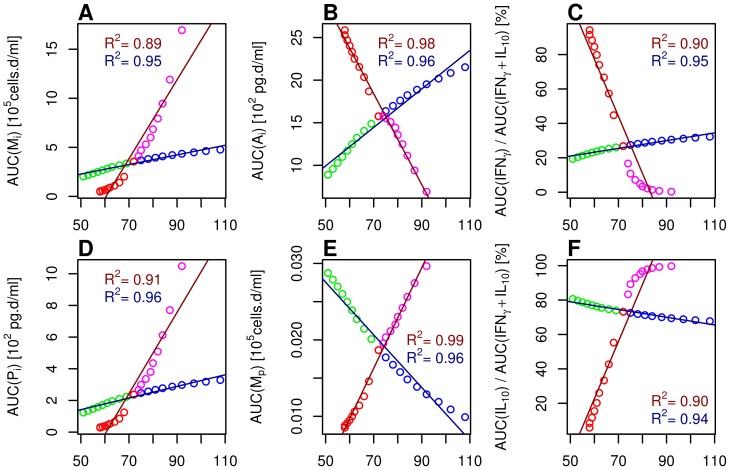
Linear regressions between the infection duration and immune components of interest.The immune components selected are the area under the curve (AUC) of A: infected macrophages (), B: innate antiviral cytokines (), D: pro-inflammatory cytokines (), and E: phagocyting macrophages (); and the relative AUC of C:  and F: . Two regressions were performed for each component: (i) for scenarios SBSA (dark red), in which the antiviral cytokine synthesis is higher (S0SB, red dots) or lower (S0SA, magenta dots) than in the reference scenario; (ii) for scenarios S1S2 (dark blue), in which the macrophage permissiveness is lower (S0S1, green dots) or higher (S0S2, blue dots) than in the reference scenario. Scenarios are defined in Table 2.